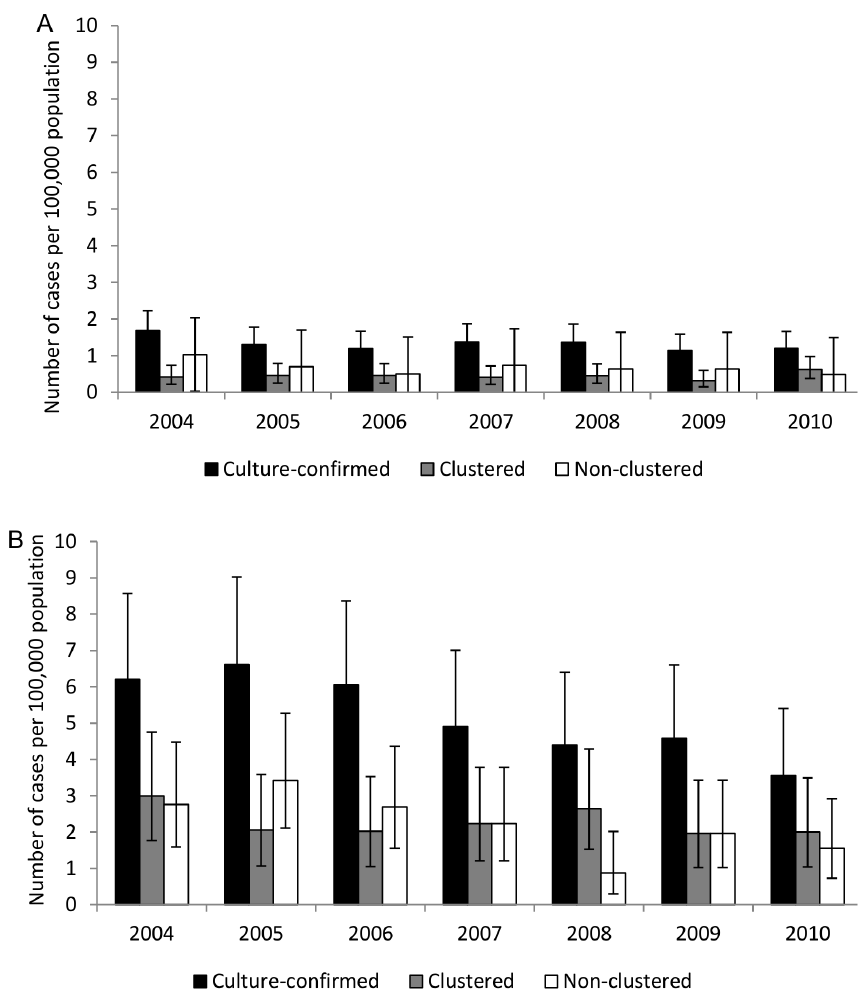
Figure 4. Comparison of culture-confirmed, clustered, and non-clustered tuberculosis cases by race/ethnicity. Comparison of incidence trends of culture-confirmed, clustered, and non-clustered cases of tuberculosis reported in Arkansas from 2004 to 2010 between two major race/ethnic groups. a: among non-Hispanic whites; b: among non-Hispanic blacks.